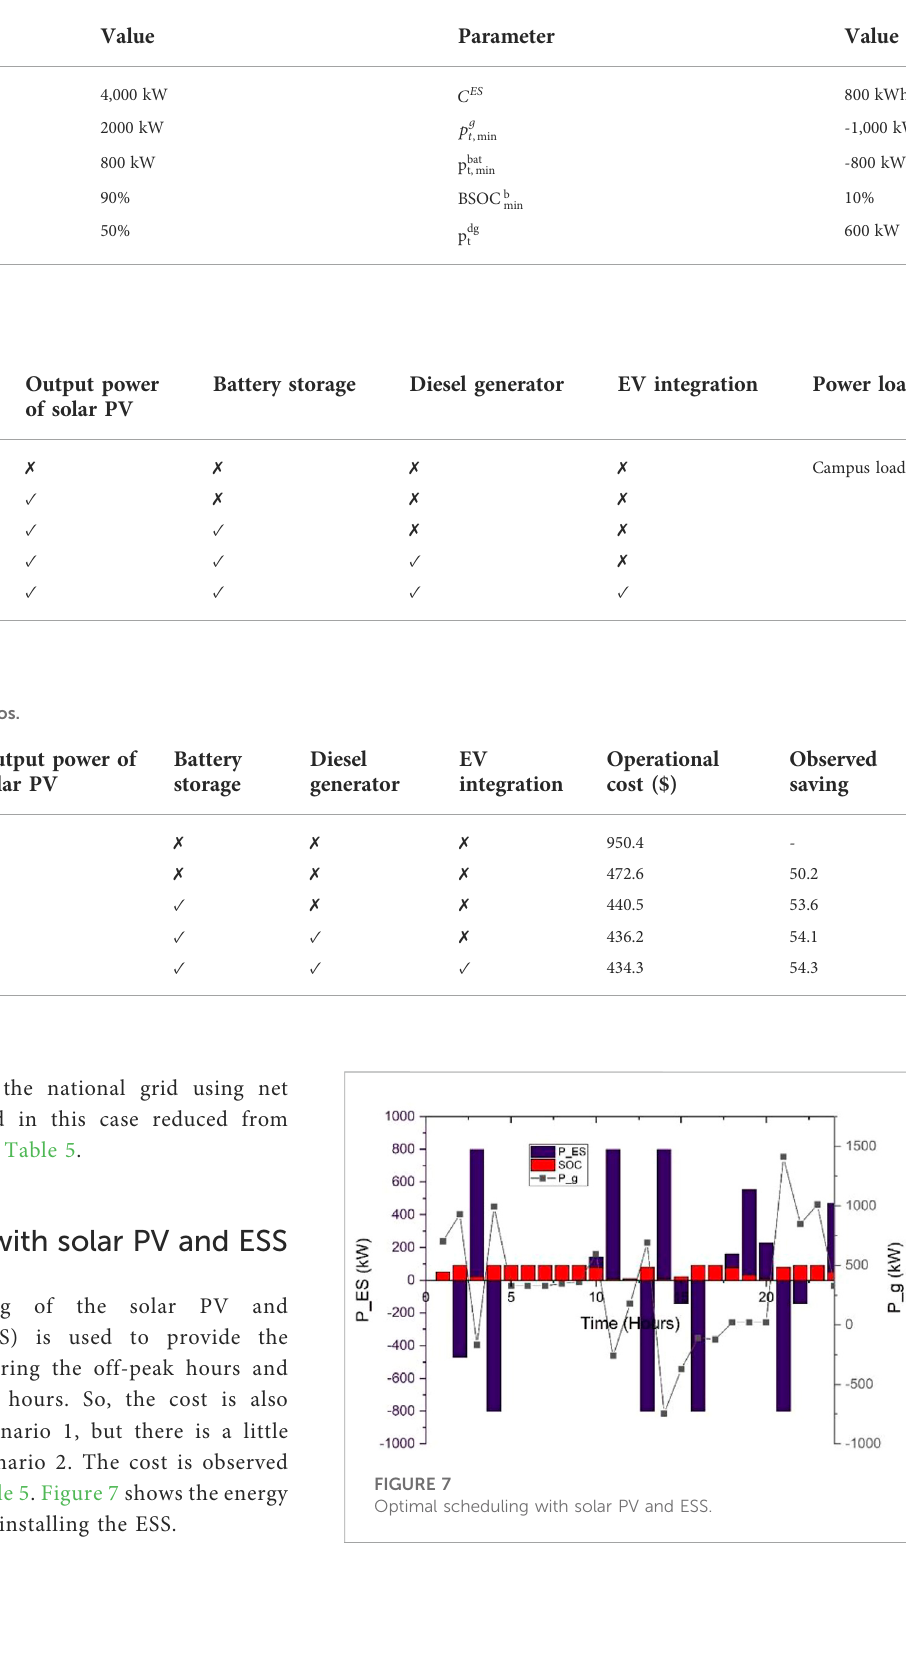
TABLE 3 Proposed system parameters.